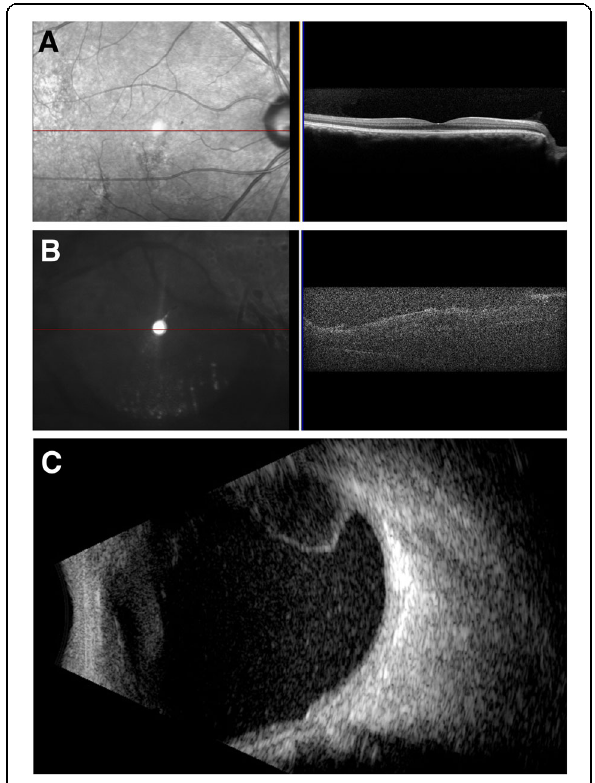
Fig. 2 Optical coherence tomography and B-scan ultrasound of both eyes. Optical coherence tomography (OCT) of the right eye was normal ( a ). In the left eye, OCT demonstrated subretinal fluid and a limited quality scan due to vitreous haze ( b ). B-scan ultrasound noted a serous retinal detachment OS without any retinal breaks ( c )